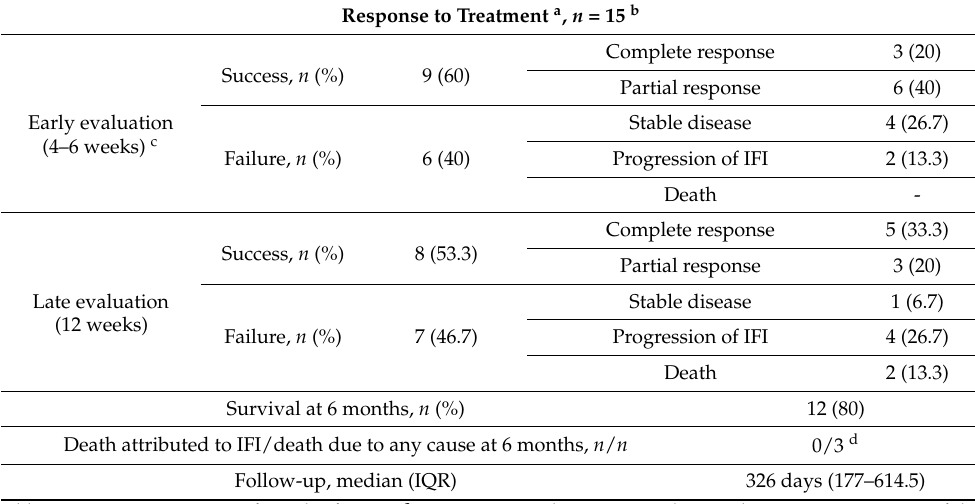
Table 5. Response to treatment in proven or probable IFI